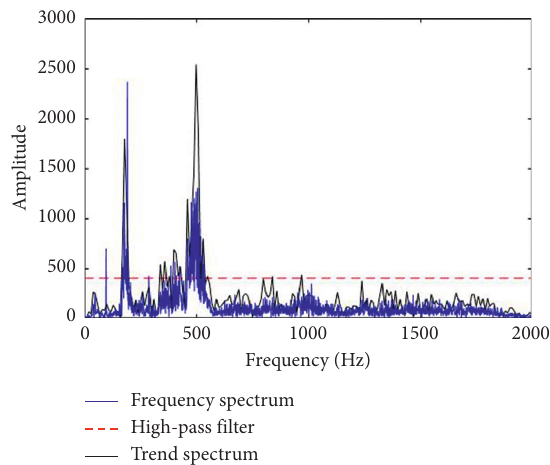
Figure 2: The selection of the signal trend spectrum and modal